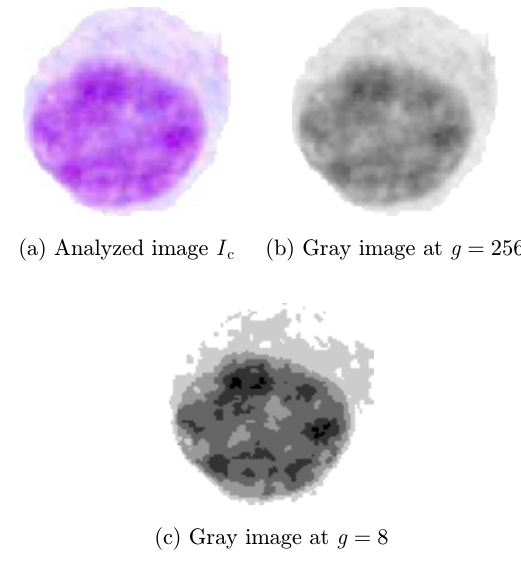
Fig. 1. Gray processing at di®erent gray levels of a leukocyte